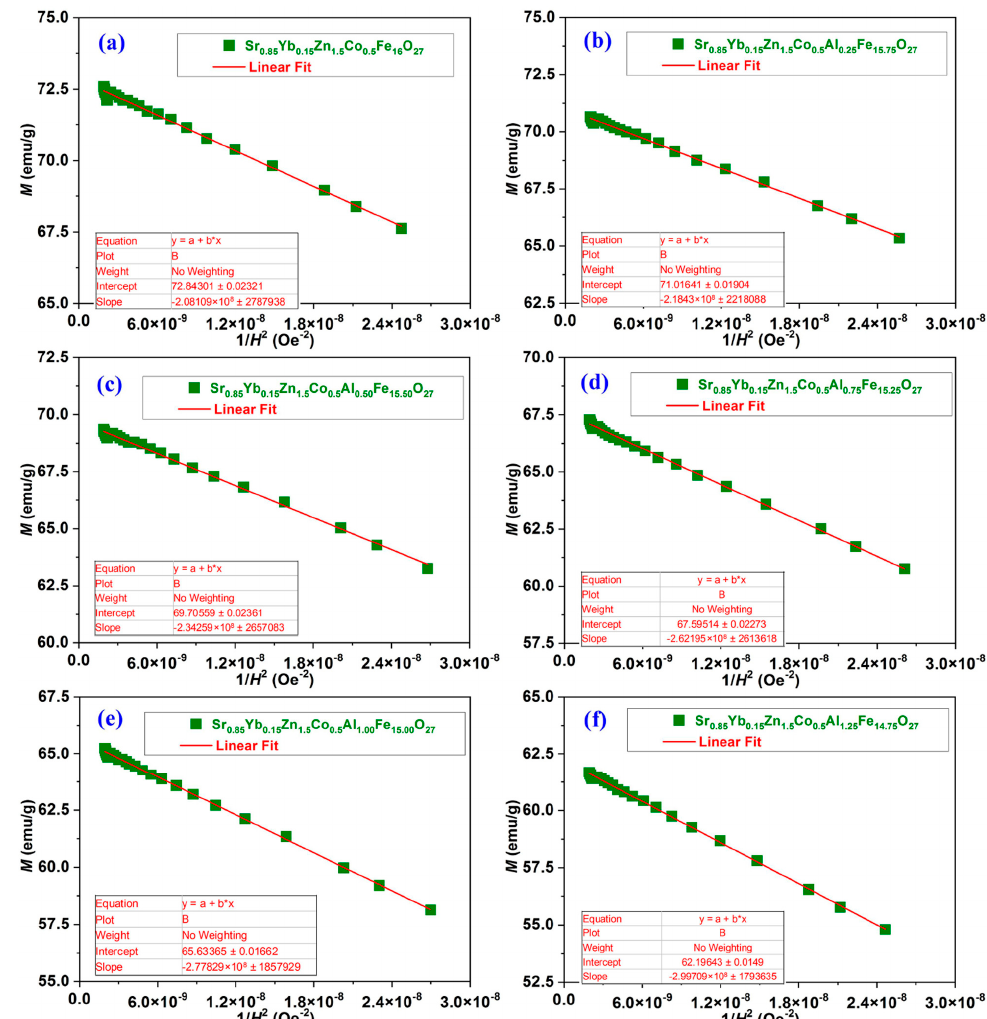
Figure 10. Plots of magnetization ( M ) versus 1/ H 2 for the W-type SrYb hexaferrite Sr 0.85 Yb 0.15 Zn 1.5 Co 0.5 Al x Fe 16 − x O 27 with Al content (x) of ( a ) x = 0.00, ( b ) x = 0.25, ( c ) x = 0.50, ( d ) x = 0.75, ( e ) x = 1.00, and ( f ) x = 1.25.